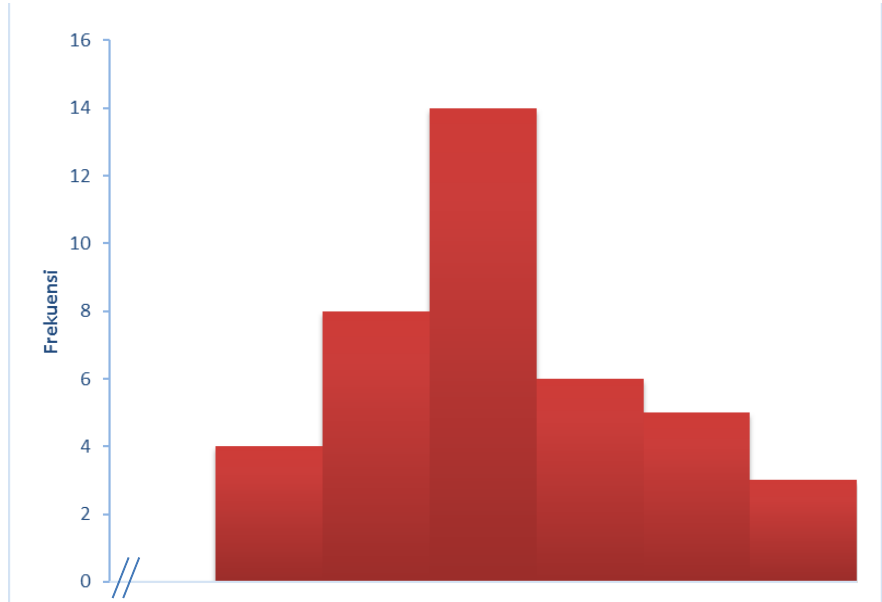
Figure 1 Understanding Score Histogram Reading Students Given a KW Learning